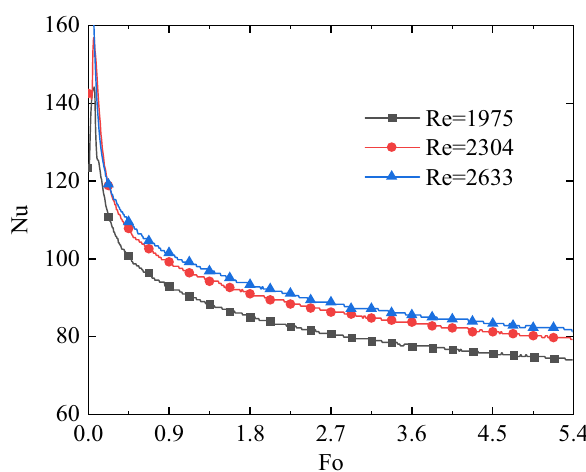
Fig. 13 Change of Nu with time in backward flow